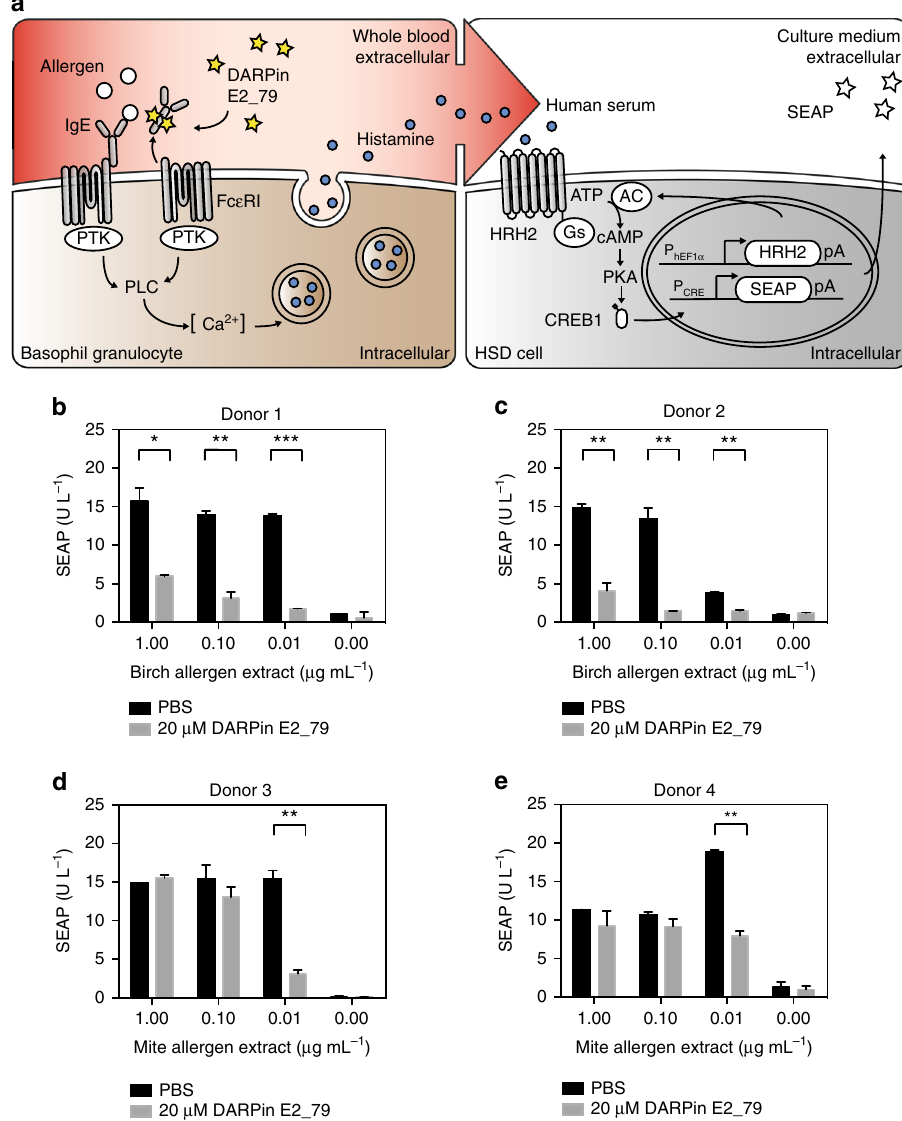
Fig. 3 Functional characterization of DARPin E2_79 produced in mammalian cells. a Illustration of the operational procedure for the analysis of mammalian cell-produced DARPin E2_79. The basophil granulocytes in donor blood samples exposed to the allergen as well as DARPin E2_79 activate their Fc ε RI receptor and trigger the underlying signaling cascade involving protein tyrosine kinase (PTK) and phospholipase C (PLC) which results in a calcium (Ca 2+ ) surge and corresponding release of histamine, which can be quanti fi ed using reporter cells containing a histamine sensor device (HSD cells).